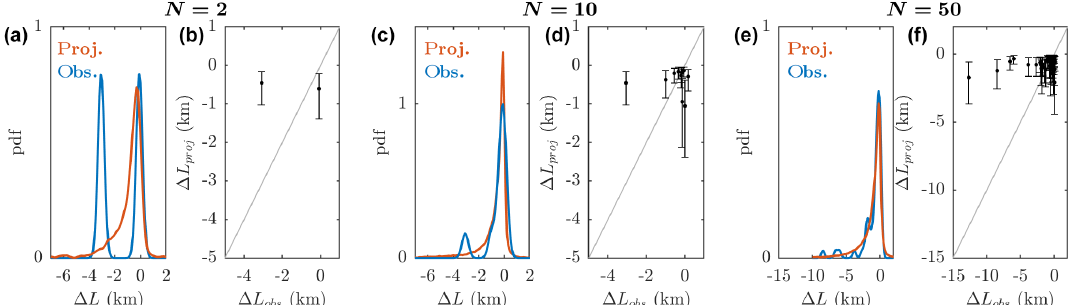
Figure 8. Validation of retreat parameterization on the observed terminus position change between 1995–2005 and 2005–2015. Note that (cid:49)L < 0 indicates retreat. In (a) and (b) we select two glaciers at random to be the test dataset and calculate the distribution for κ (as in Fig. 5a) based on all of the remaining glaciers. As described in the text we use the distribution for κ to generate projected retreat. In (a) we compare the distributions of observed (blue) and projected (red) retreat. In (b) we plot observed versus projected retreat, where the projection uses the median and interquartile range of the κ distribution. Panels (c) and (d) are the same but select 10 glaciers at random, while (e) and (f) select 50 glaciers at random.